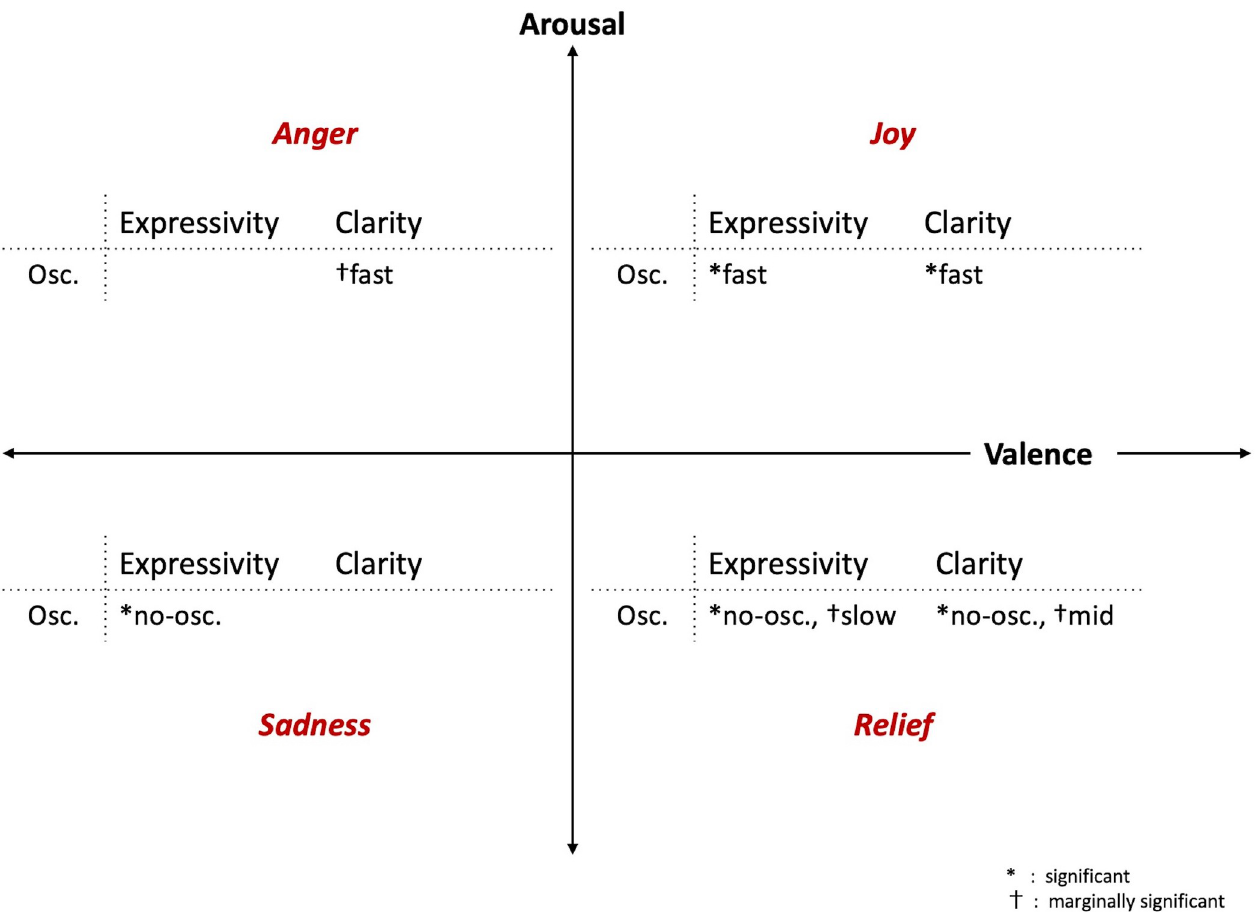
Fig 10. Effective movements for different emotions in long-term expressions. Summary of the effective vertical movements on improvements of expressivity and clarity for long-term emotion expressions of the robot. In the figure, the notation no-osc . indicates the no-oscillation condition.